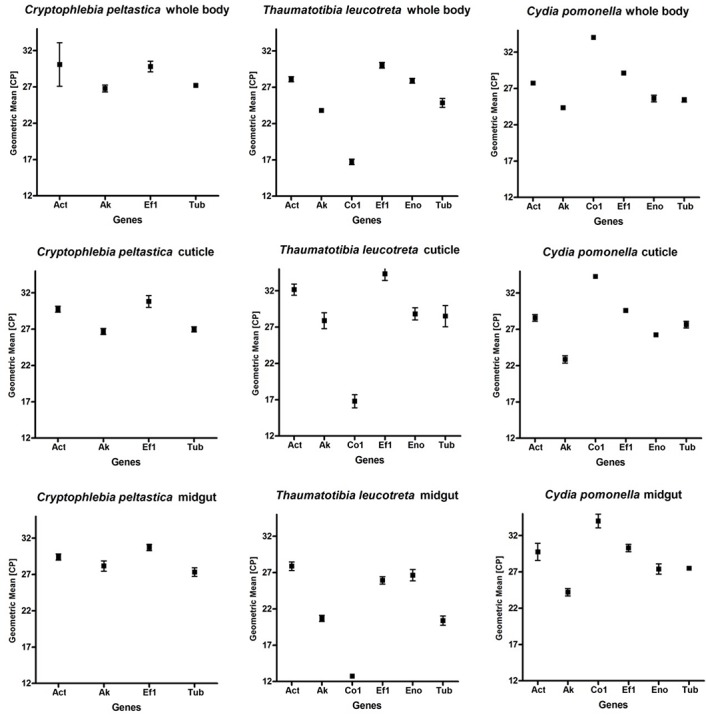
Expression levels for candidate reference genes for three different tissue types and species of Tortricidae.Expression levels of reference genes are expressed in cyclic-threshold (Cp). Boxes indicate Cp means and whiskers standard deviations from the means.